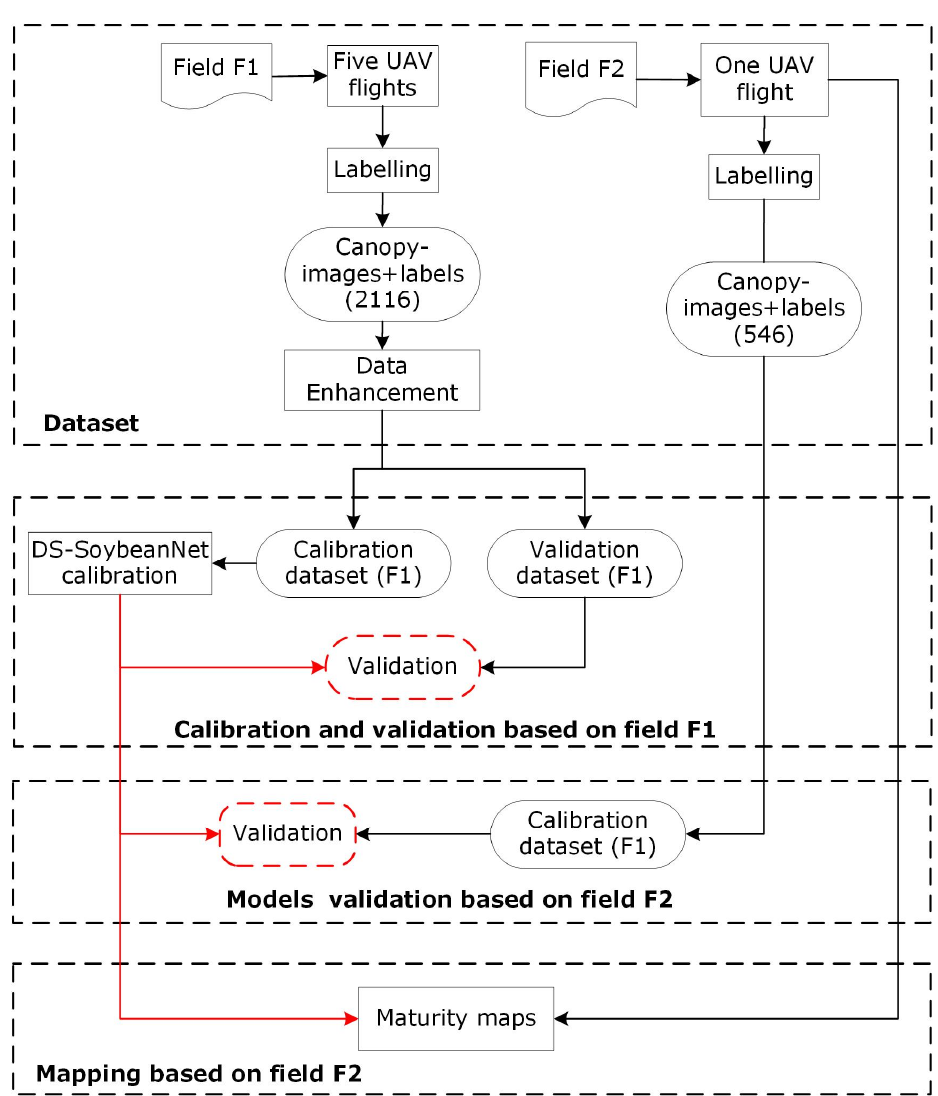
Figure 4. Flowchart of the experimental methodology.